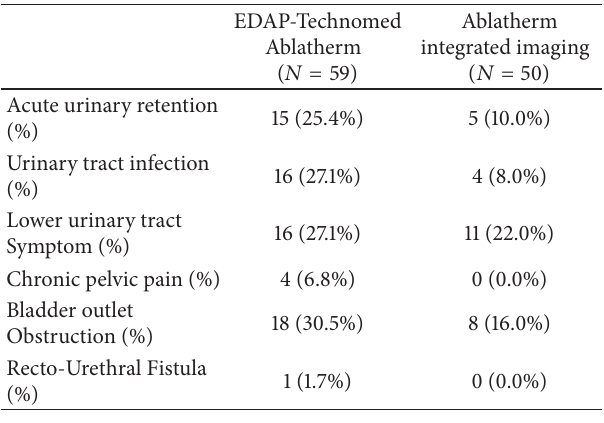
Table 4: Adverse events.